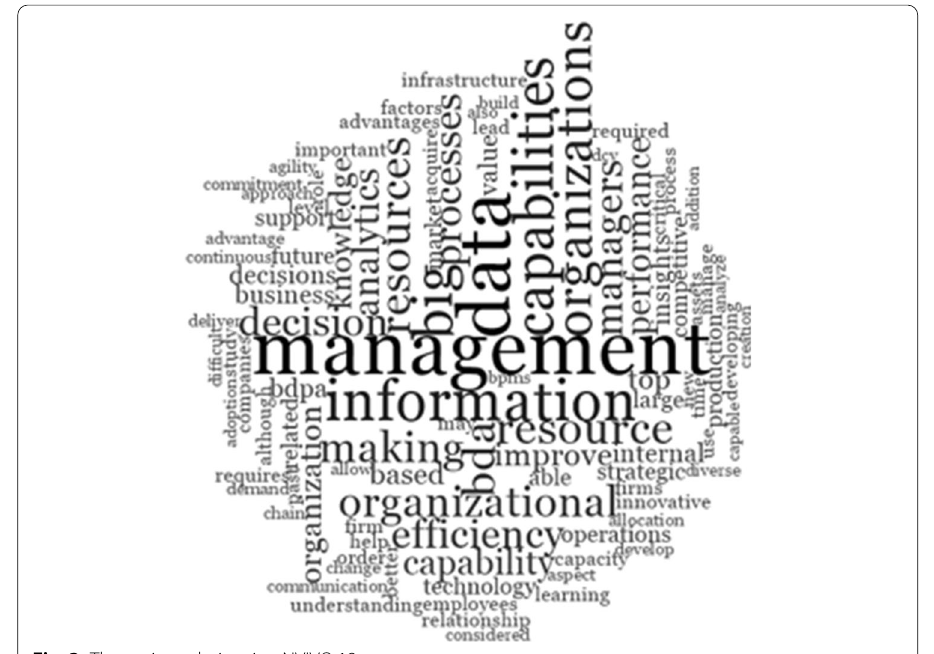
Fig. 3 Thematic analysis using NVIVO